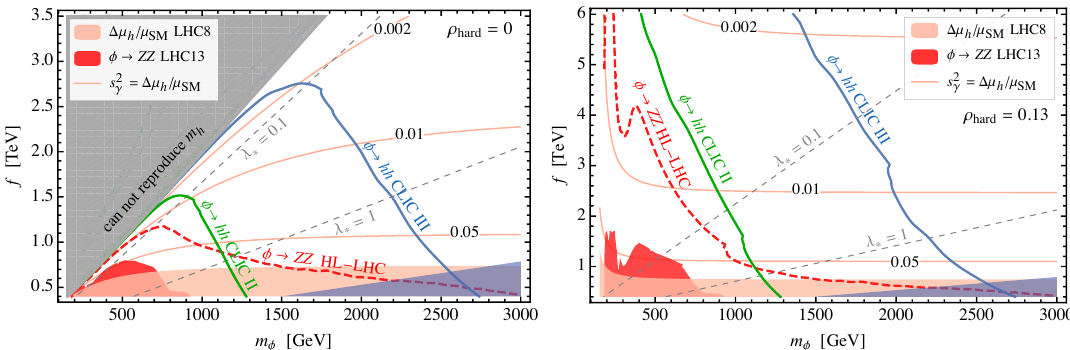
Figure 9. Constraints at 95% C.L. in the plane ( m (cid:30) ; f ). The shaded regions are the present constraints from LHC direct searches for (cid:30) ! ZZ (red) and Higgs couplings measurements (pink), and the region where (cid:0) (cid:30) > m (cid:30) (dark blue). The reach at CLIC Stage 2 and Stage 3 (blue) is compared with the projections for LHC with a luminosity of 3 ab (cid:0) 1 (dashed red).The dashed grey lines correspond to constant values of the SO(8)-symmetric quartic (cid:21) (cid:3) . Left: only soft Z 2 breaking (cid:26) hard = 0. Right: a hard Z 2 breaking quartic (cid:26) hard = 0 :